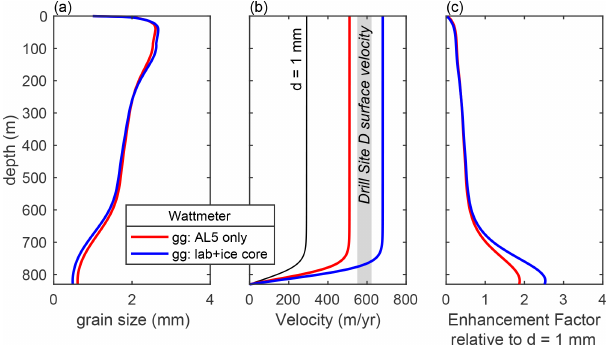
Figure 8. (a) Grain size, (b) velocity, and (c) strain rate enhance- ment factor calculated as a function of depth for Drill Site D (Lüthi et al., 2002). Red and blue curves correspond to calculations using the grain growth parameters from Azuma et al. (2012) experiment AL5 and the joint fit of the experimental and ice core data, respec- tively. The black curve in panel (b) corresponds to a case with a constant grain size of 1mm. Enhancement factor is calculated as the ratio of the strain rate determined by the wattmeter to the strain rate calculated assuming a constant grain size of